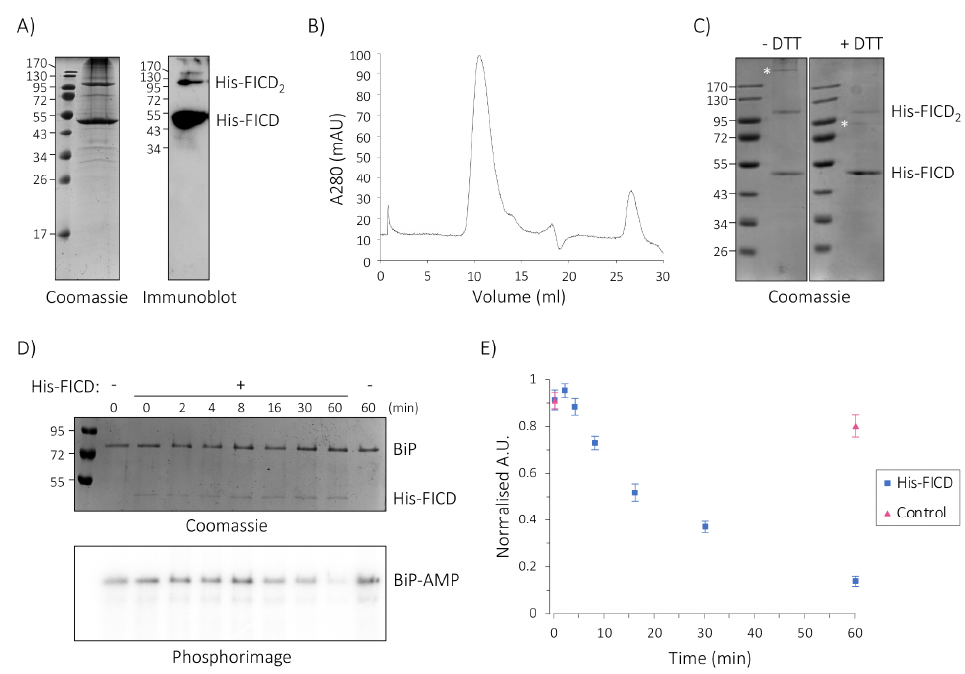
Figure 5. Solubilised His-FICD can be purified in a correctly folded, active conformation. ( A ) Non- reducing SDS-PAGE gel stained with Coomassie (left) and an immunoblot developed with α -FICD antiserum (right) of the IMAC purified FICD. Monomeric His-FICD (53 kDa) and dimeric His-FICD 2 (106 kDa) are annotated. ( B ) SEC analysis of IMAC-purified FICD. Protein absorbance (A 280 ) is plotted against the elution volume. ( C ) Non-reducing (left) and reducing (right) SDS-PAGE gel analysis of SEC-purified FICD. Where indicated, proteins were reduced using 10 mM dithiothreitol (DTT). Unidentified bands are marked with an asterisk (*). ( D ) Time-dependent deAMPylation of radioactively labelled BiP- α -[ 32 P]-AMP in the presence and absence of His-FICD. The reaction was sampled and quenched at indicated time-points and analysed by SDS-PAGE. Coomassie stain (top) depicts the total protein content of the reaction, and the phosphorimage (bottom) shows the radioactive BiP-AMP signal. Representative gel and phosphorimage for seven experiments. ( E ) Quantification of deAMPylation of BiP-AMP in the presence (blue squares) and absence (red triangles) of His-FICD. Plotted are normalised mean values ± standard error of the mean (SEM) from seven replicates, performed in four independent experiments (one single experiment and three performed in